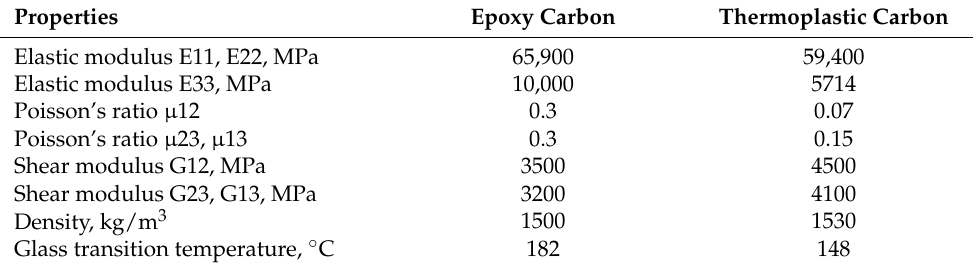
Table 1. Properties of